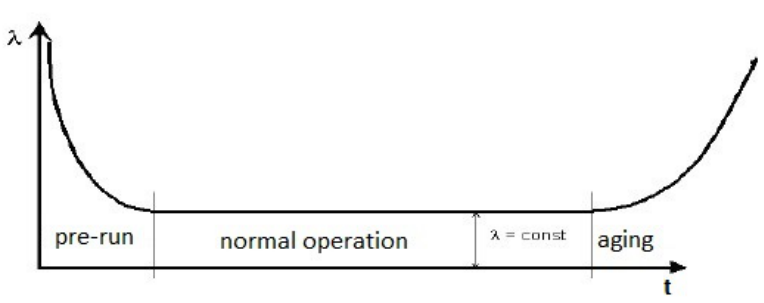
Figure 1. A U -shaped (bathtub) hazard rate